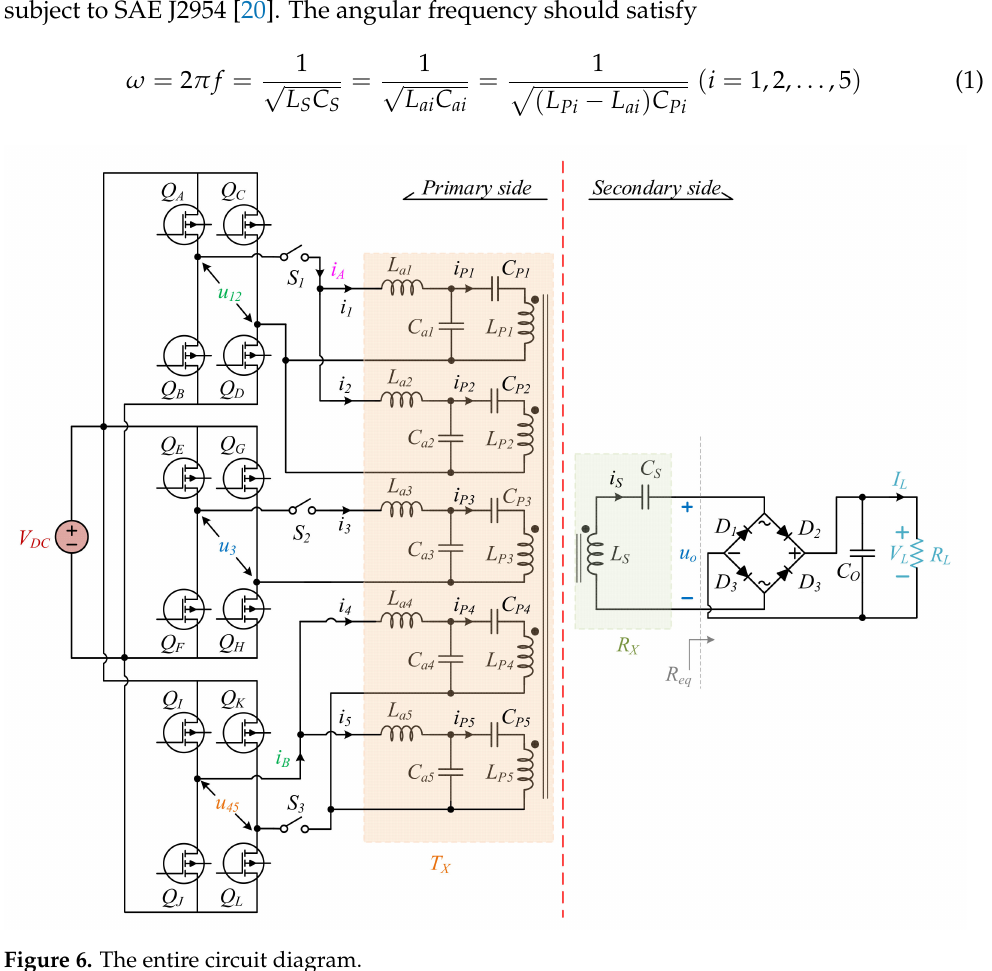
Figure 6. The entire circuit